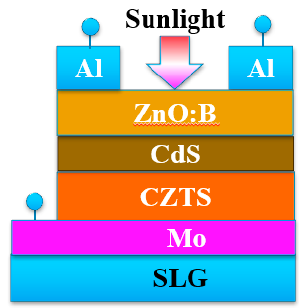
Figure 3. Structure of CZTS solar cell.